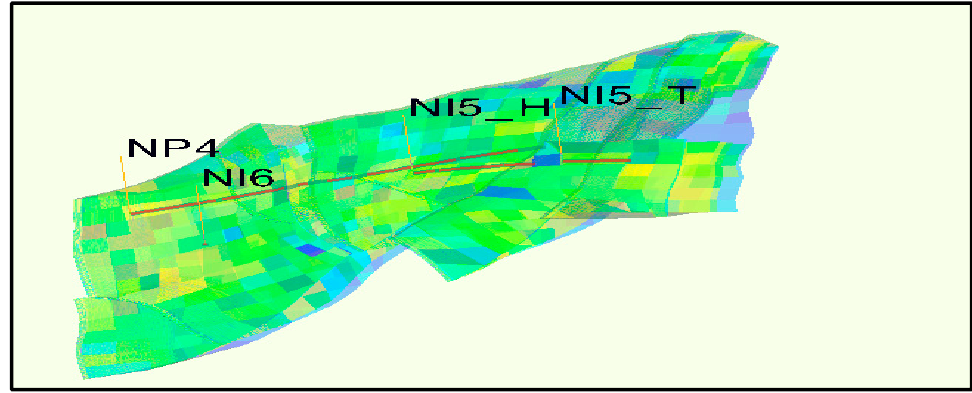
Figure 17. Locations of Injectors NI6, NI5_H, and NI5_Twith respect to Producer NP4. Energies 2020 , 13 , x FOR PEER REVIEW